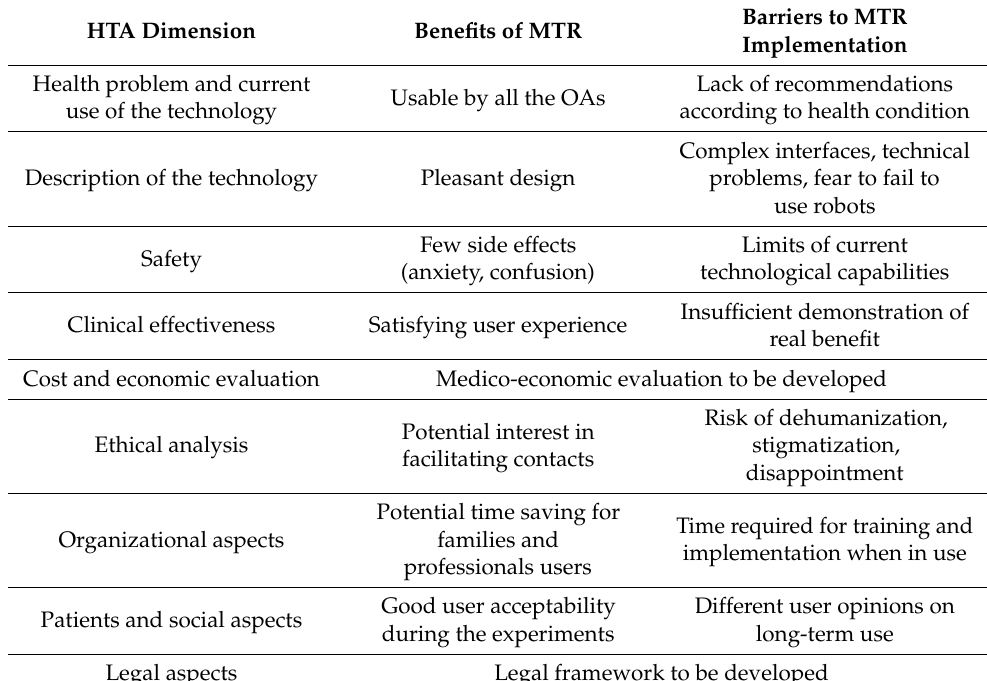
Table 4. Summary of benefits and barriers to the implementation of robots in daily practice (HTA: health technology